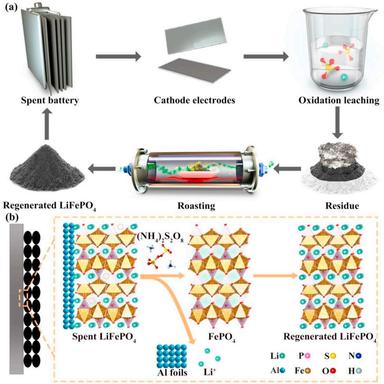
(a) Flow chart of regenerating LFP cathode material by ammonium persulfate oxidation leaching. (b) The schematic diagram of oxidation leaching of LFP.